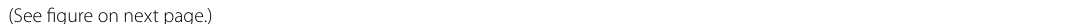
Fig. 3 Functional effects of lncRNA-ATB knockdown in HK ‐ 2 cells exposed to COM. a The interference efficiencies of interfering lentivirus were validated by qRT ‐ PCR. b Cell damage was assessed by a Cytotoxicity LDH Assay Kit. c , d The expression levels of KIM-1 were detected by western blot analysis. e The expression levels of KIM-1 were detected by immunofluorescence. f Cell proliferation was assayed by CCK-8. g – k Cell apoptosis was analysed by flow cytometry g , h and TUNEL staining ( i , j ). All above the experiments were repeated 3 times, values are mean SD; * P < 0.05, ± COM group. Scale bars 200 ** P < 0.01 VS . sh-NC group; ## P < 0.01 VS . sh-NC + =